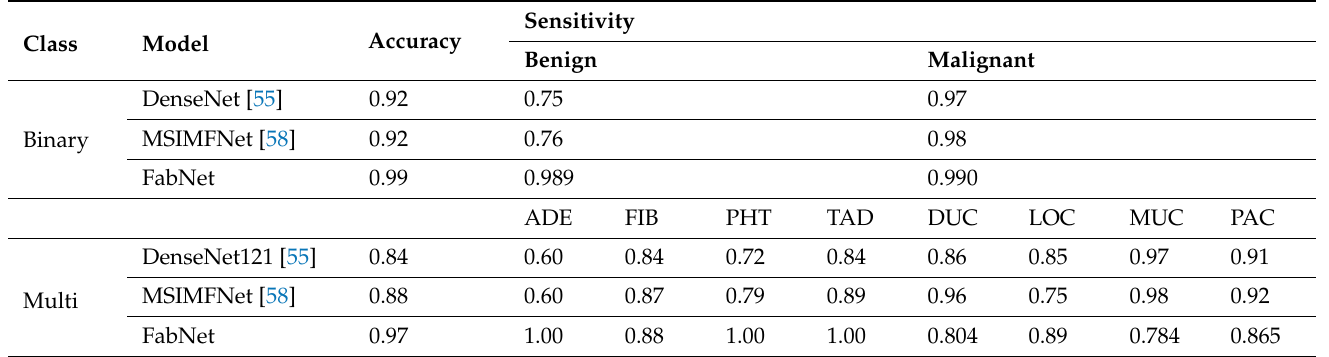
Table 5. Patch wise classification results of FabNet for BreakHis dataset on magnification level 200 × in terms of accuracy and sensitivity metrics.